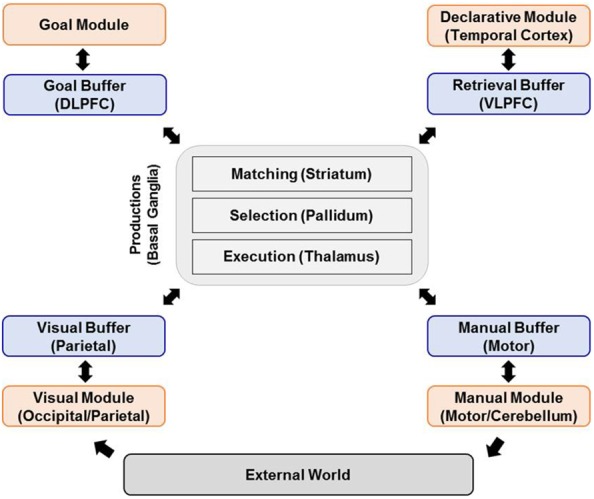
Overview of ACT-R modules (revised based on Anderson et al., 2004).